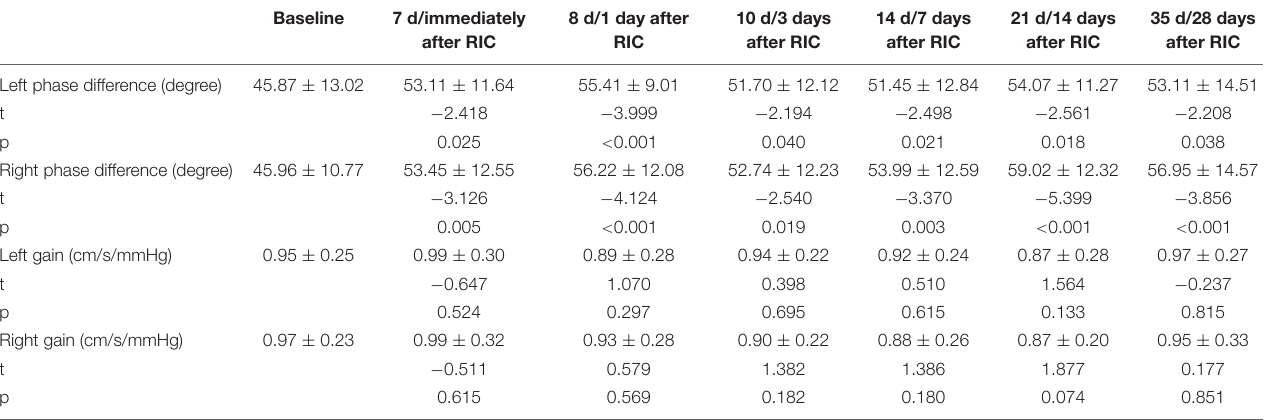
TABLE 5 | DCA parameters in participants after RIC.